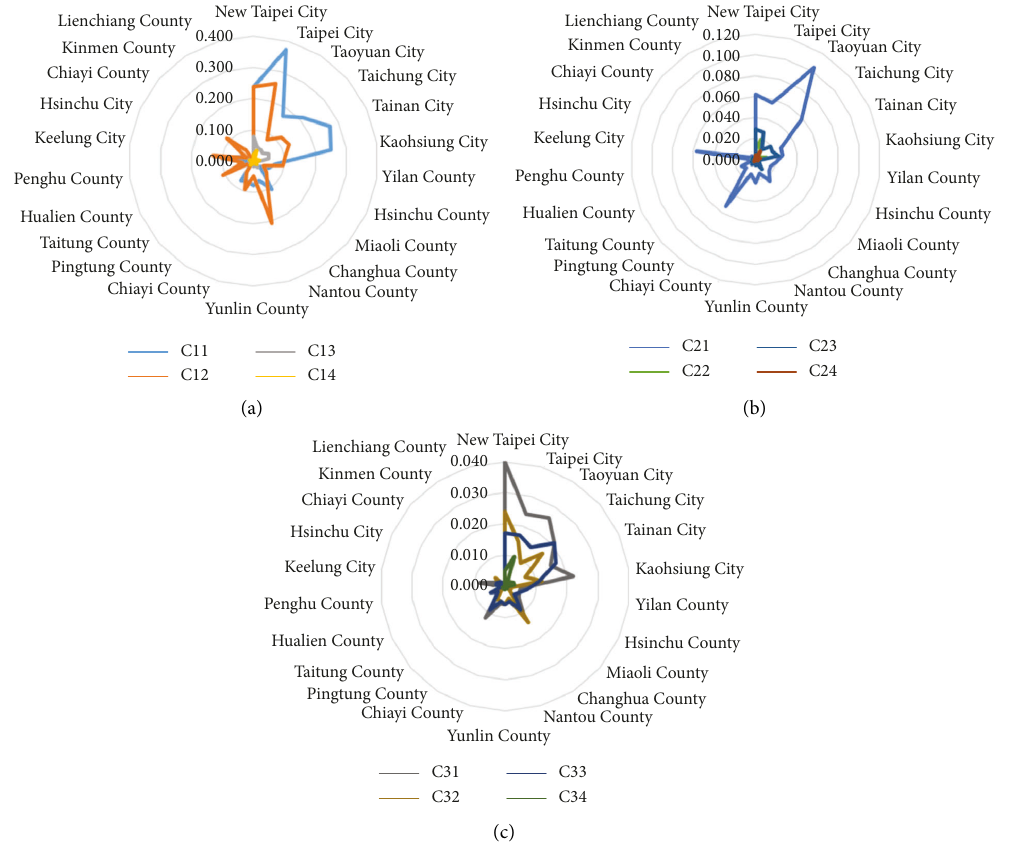
Figure 4: Normalized data after weights had been